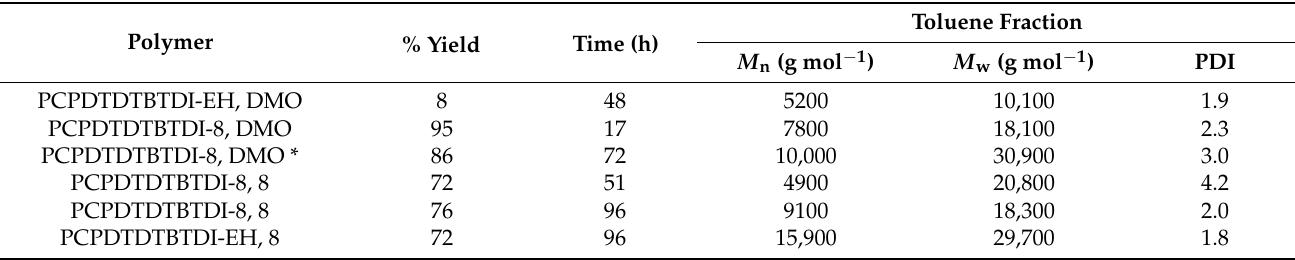
Table 1. The percentage yield, reaction time, weight, and number average molecular weights with polydispersity indexes of PCPDTDTBTDI-EH, DMO, PCPDTDTBTDI-8, DMO, PCPDTDTBTDI-8, 8, and PCPDTDTBTDI-EH, 8. Polymer %